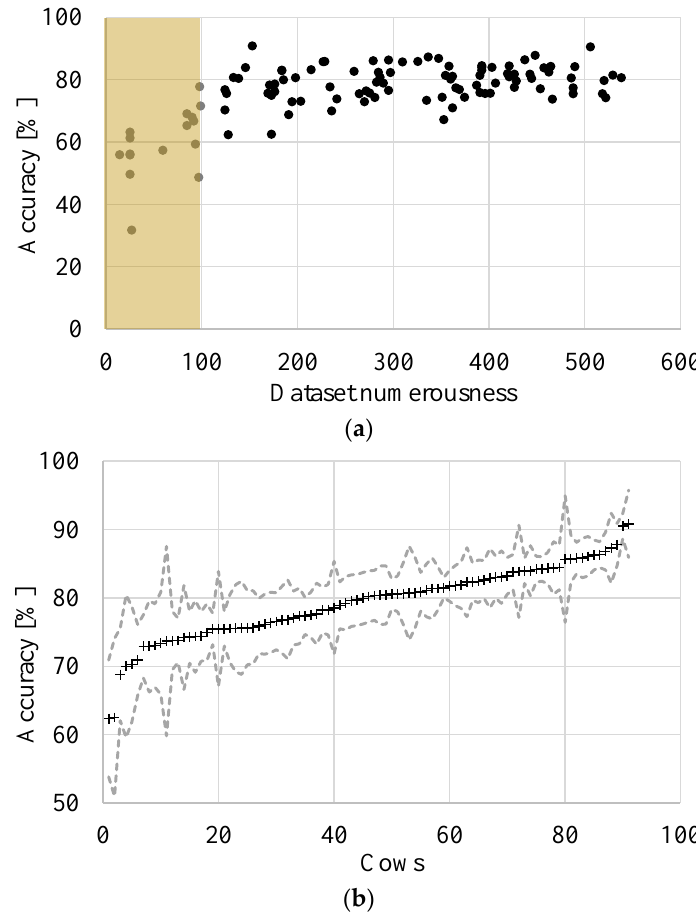
Figure 7. Main results obtained for scenario A for the 91 cows of the study. ( a ) Median accuracy for each cow vs. dataset numerousness; ( b ) median accuracy ± standard deviation for each cow sorted ascendingly.